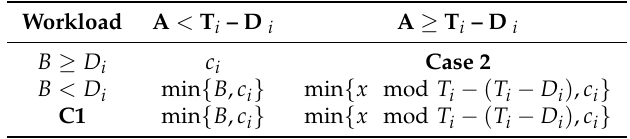
Table 1. The workload in the incomplete period under different value ranges of A and B